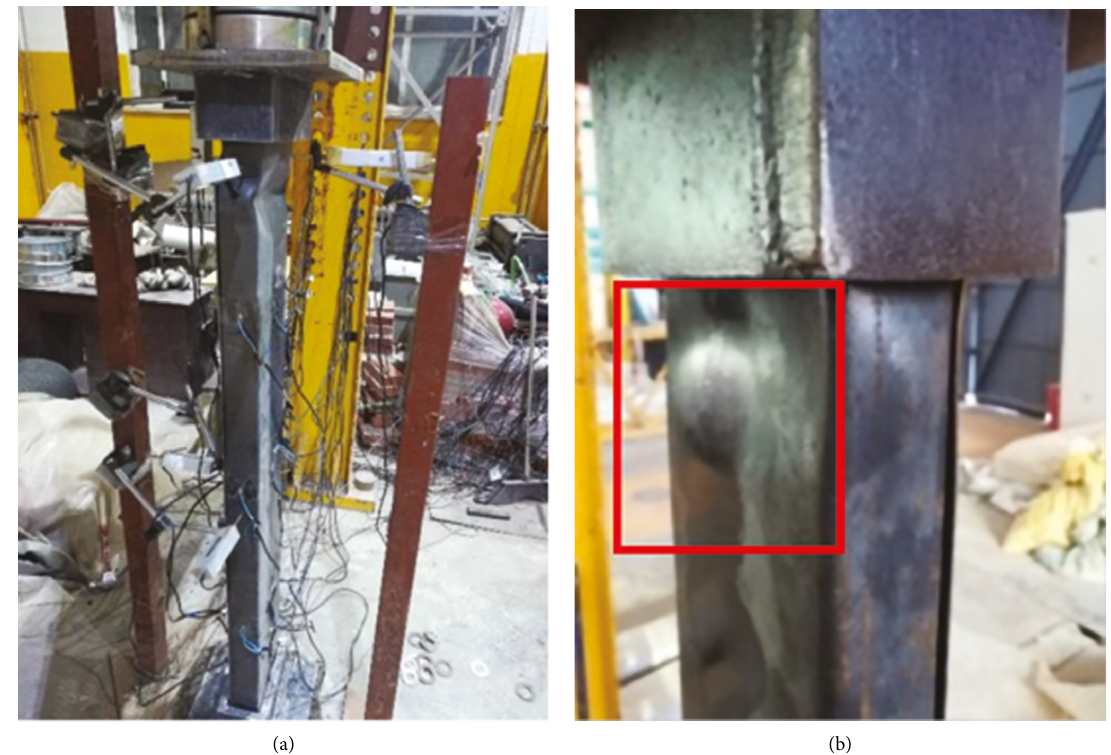
Figure 9: Damage of the specimen Z200-3.0-k. (a) Overall. (b) Local buckling.